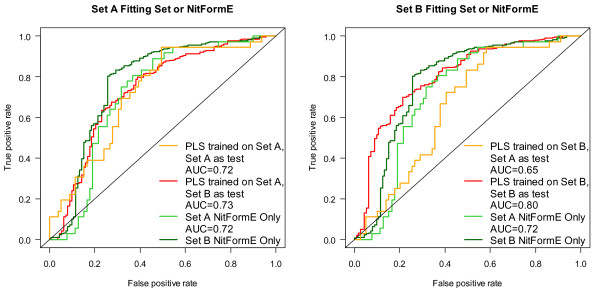
Extrapolation from one aryl-amine data set to another: cross-set performance. Comparison of the performance obtained when a PLS (1-component) model is fitted using all of the data in Set A and used to predict Set B (left plot, solid red line) to that obtained when fitting to the data in Set B and using that model to predict the data in Set A (right plot, solid orange line). The performance for the training set is also shown in dashed lines and the performance of using only the nitrenium formation energy is shown with a dot-dashed line.